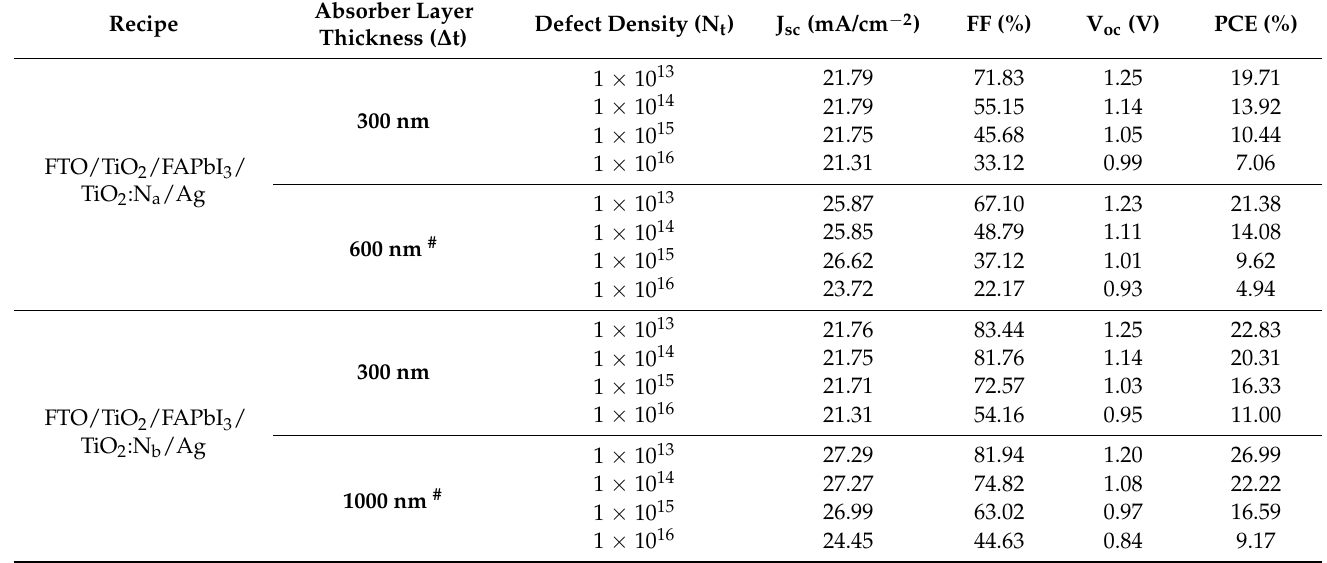
Table 6. Performance parameters for proposed recipes with ∆ N t and ∆